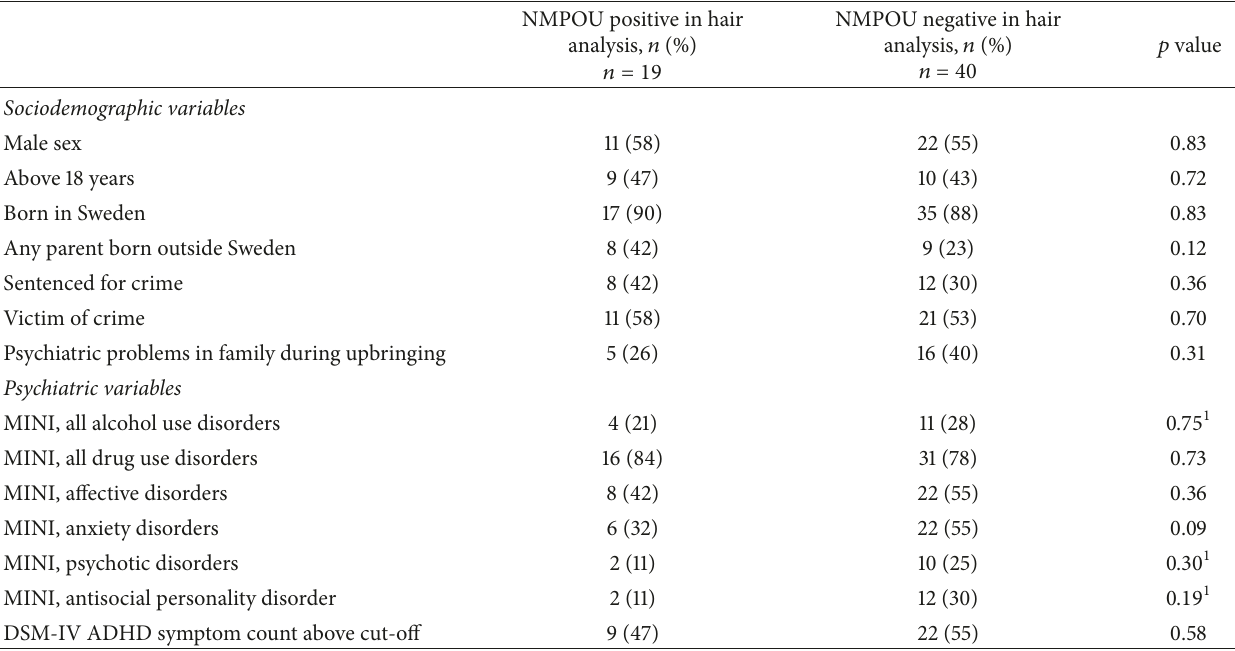
Table 3: Nonmedical prescription opioid use (NMPOU), detected by hair analysis, with reference to sociodemographic and psychiatric variables ( 𝑛 = 59